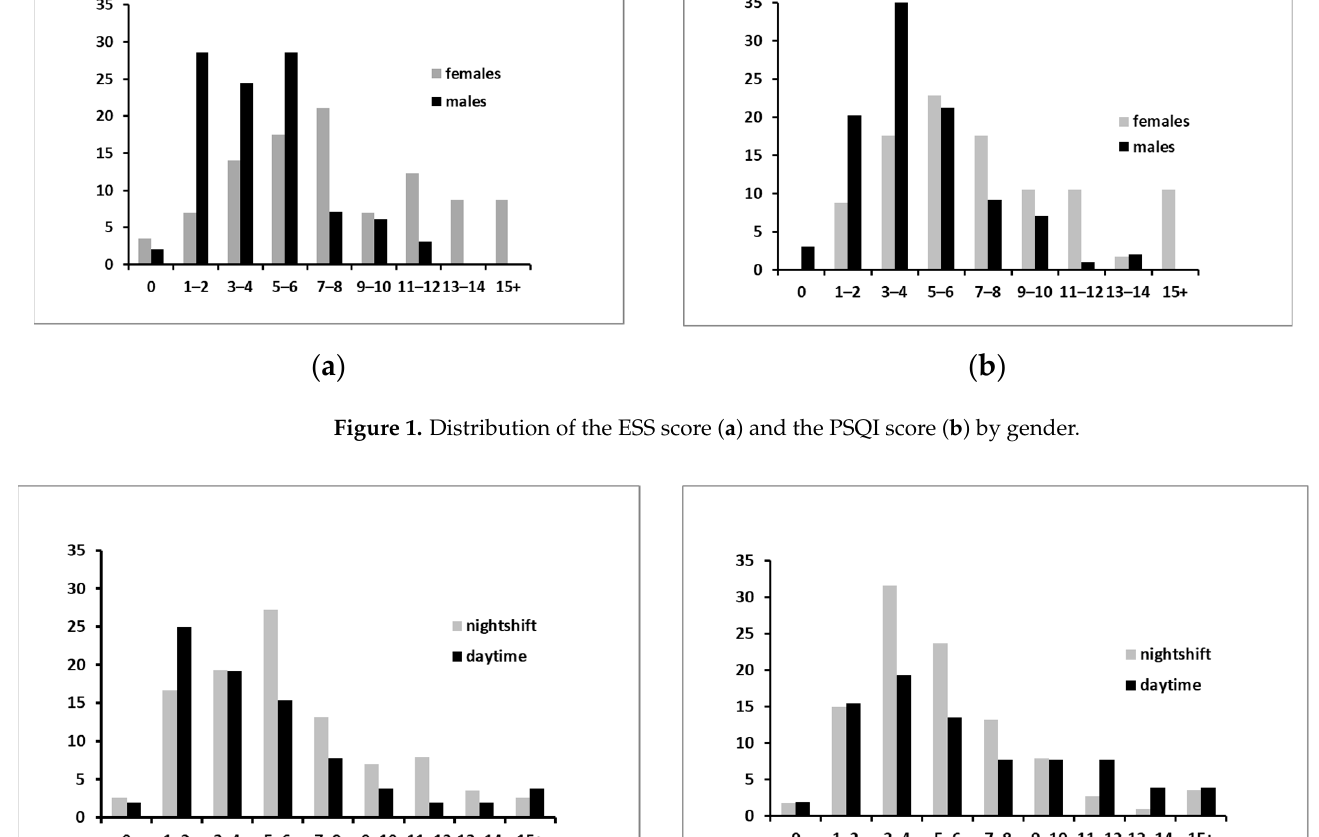
Figure 1. Distribution of the ESS score ( a ) and the PSQI score ( b ) by gender. less frequently represented among nightshift workers (males: χ 2 = 1.83, p = 0.176; females: χ 2 = 0.39, p = 0.534; total: χ 2 = 2.18, p = 0.140).